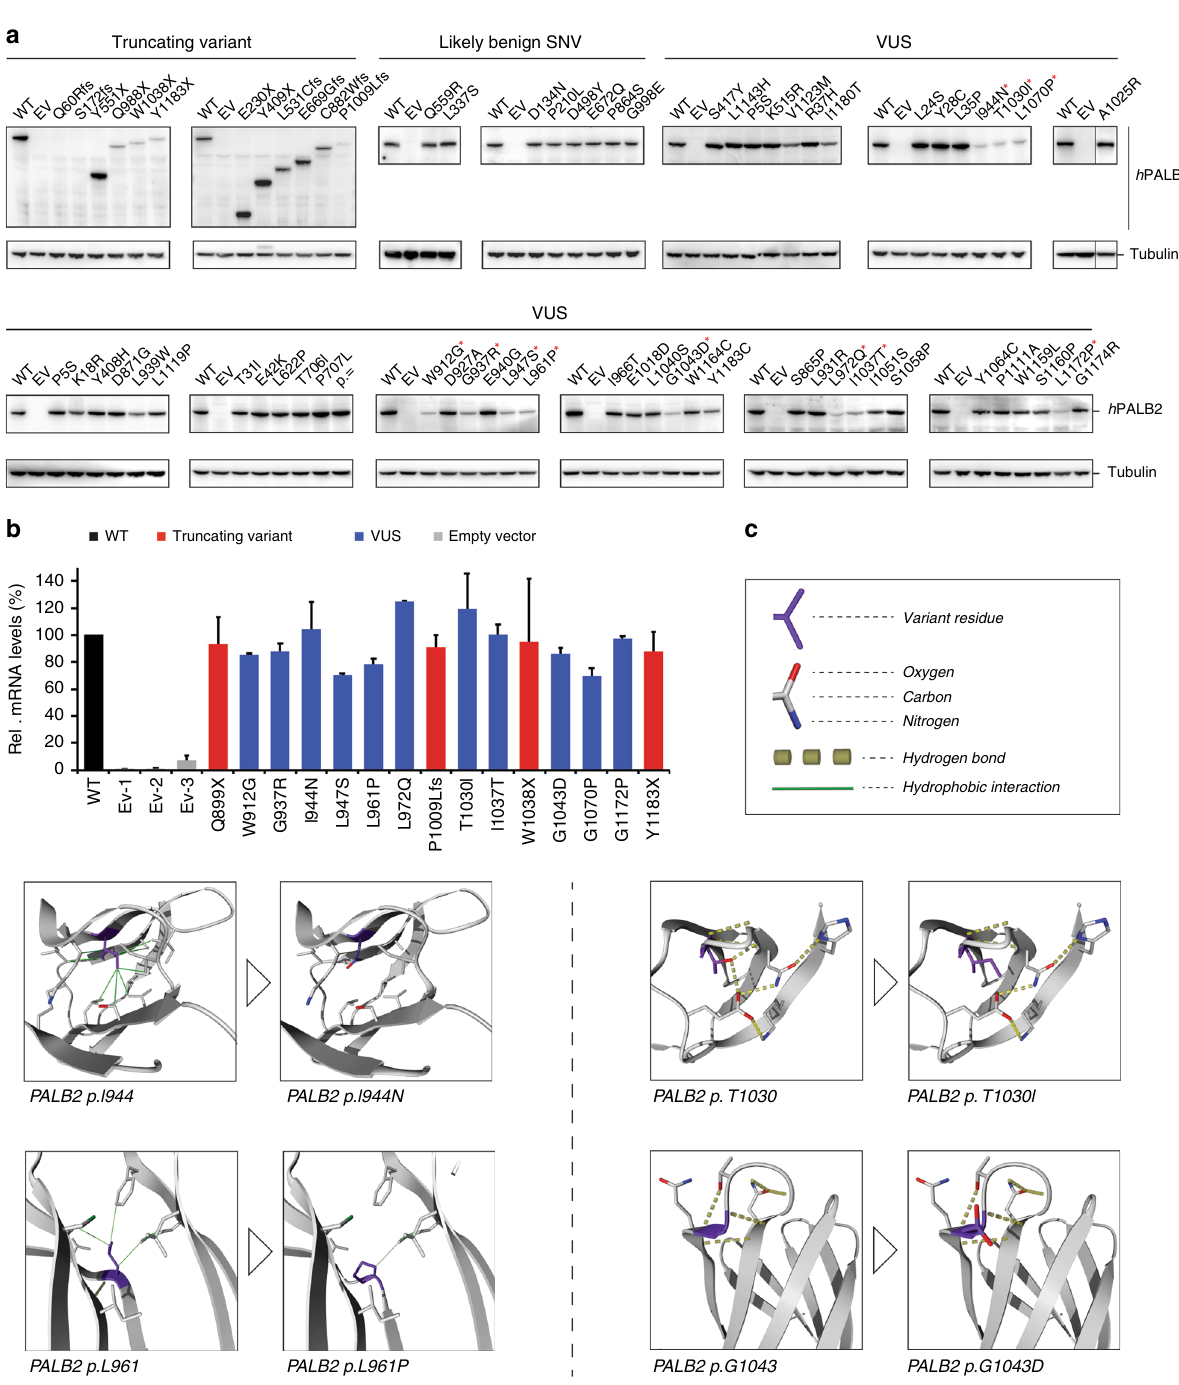
Fig. 4 Effect of PALB2 variants on protein expression and/or stability. a Western blot analysis of the expression of human PALB2 variants in Trp53 KO / Palb2 KO mES cells using an antibody directed against the N-terminus of PALB2. Wild-type (WT) human PALB2 and empty vector (Ev) served as controls on each blot. Tubulin was a loading control. Marked PALB2 variants (red *) showed low levels of protein expression. b RT-qPCR analysis of human PALB2 variants from ( a ) with low expression levels (red *). Primers speci fi c for human PALB2 cDNA and the Pim1 control locus were used. Data represent the mean percentage (±SEM) of PALB2 mRNA relative to WT, which was set to 100%, from two independent RNA isolation experiments. Variants/conditions are categorized by color as either WT (black), truncating variant (red), VUS (blue) or empty vector (Ev, grey). Ev-1, -2, -3 refer to Ev controls from three different replicates. c Partial structures of the PALB2 WD40 domain showing the effect of 4 PALB2 variants exhibiting low protein expression as shown in ( a ). Partial structures without and with variant are shown side by side for each variant, indicating loss of stabilizing interactions (but not any possible conformational changes). Source data are provided as a Source Data fi